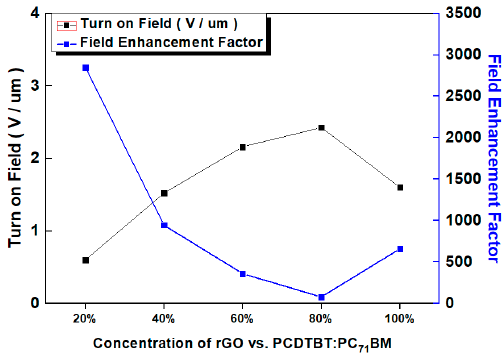
Figure 6. Variation of the turn on field (black line) and the enhancement factor (blue line) in different concentrations of PCDTBT:PC 71 BM:rGO and P3HT:rGO composite inks. Table 1. Field enhancement factor and turn-on field figures classified per composite type (columns) and for HI/AcOH-reduced rGO ink with diversified